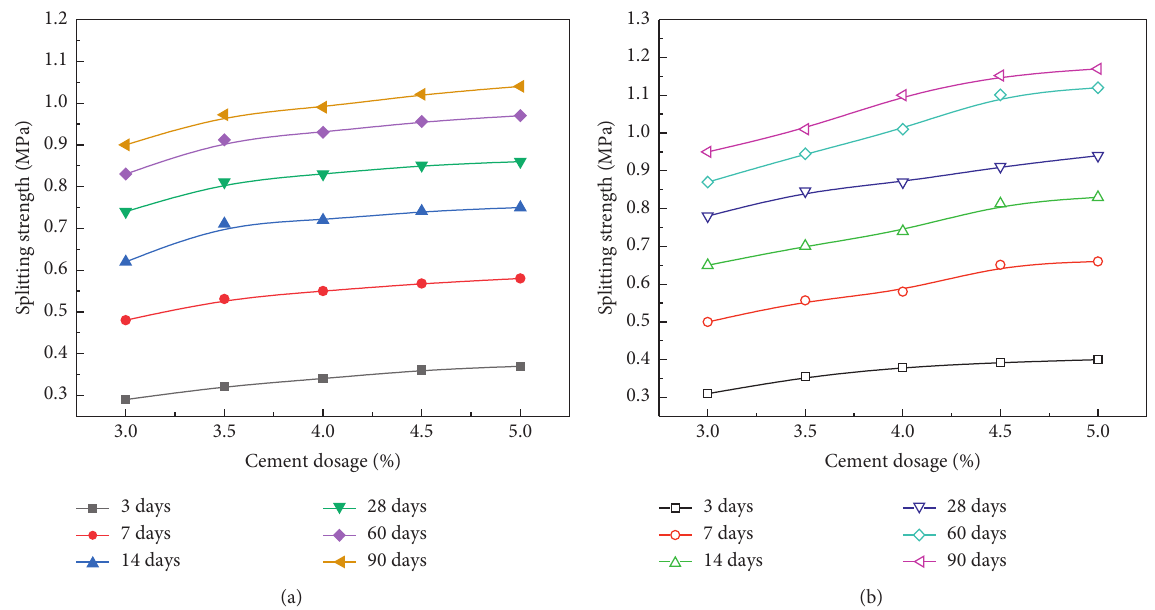
Figure 5: Effect of cement dosage on splitting strength. (a) GM gradation; (b) XM